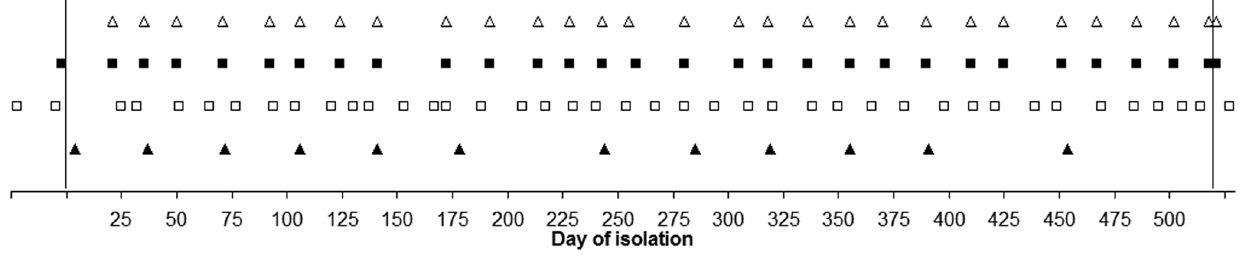
Figure 1. Testing schedule. D : maximal grip force testing. & : countermovement jump and multiple single-leg hop tests; m : first of five days wearing the actibelt H device for activity level measurements. % ; questionnaires for assessment of motivational state. Vertical lines indicate the start and end of the isolation phase.